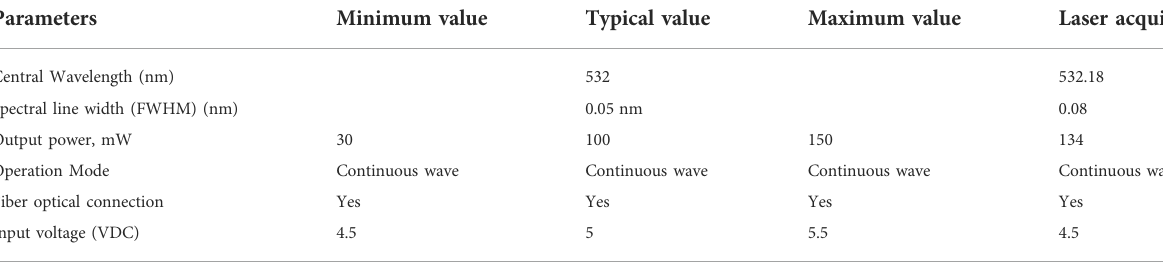
TABLE 5 Selected LunaR laser subsystem speci fi cations and